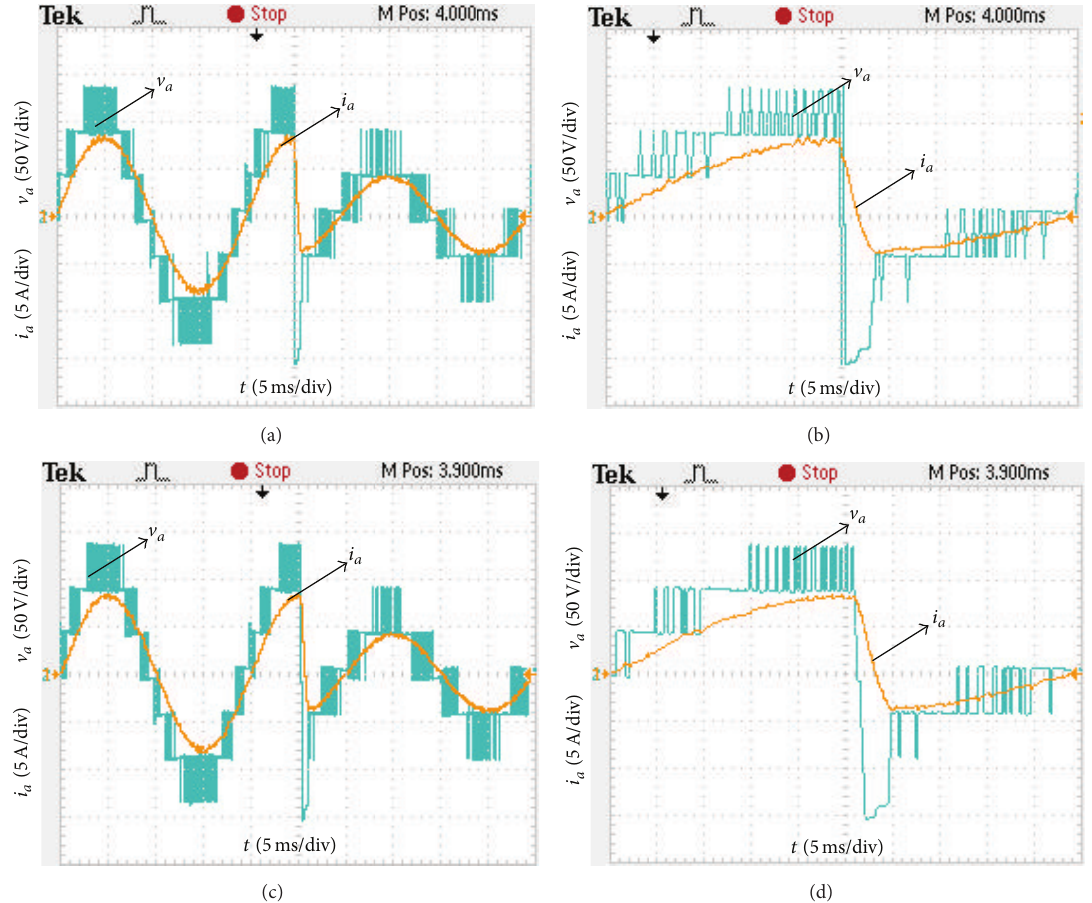
Figure 11: Grid-connected current and output voltage for a step change in the reference amplitude. (a) Grid-connected current and output voltage with conventional FS-MPC. (b) Detail of the reference step change showing the grid-connected current and output voltage with conventional FS-MPC. (c) Grid-connected current and output voltage with simplified FS-MPC. (d) Detail of the reference step change showing the grid-connected current and output voltage with simplified